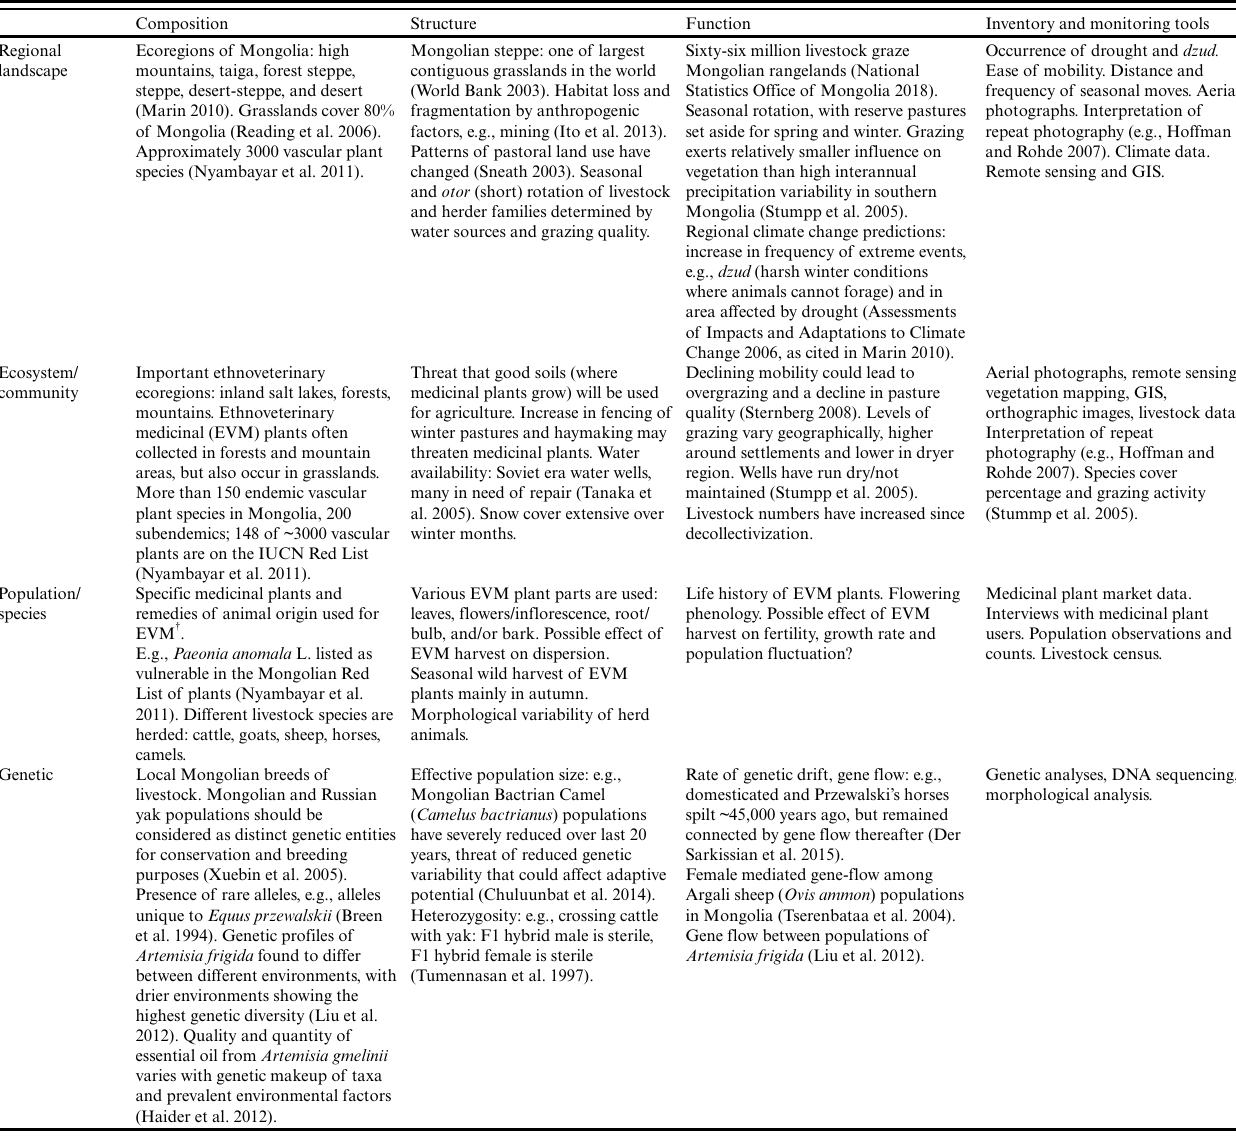
Table 1 . Examples of factors that influence biodiversity in the Mongolian pastoralist context, using compositional, structural, and functional elements of biodiversity along four levels of organization, based on the conceptual framework for biodiversity developed by Noss